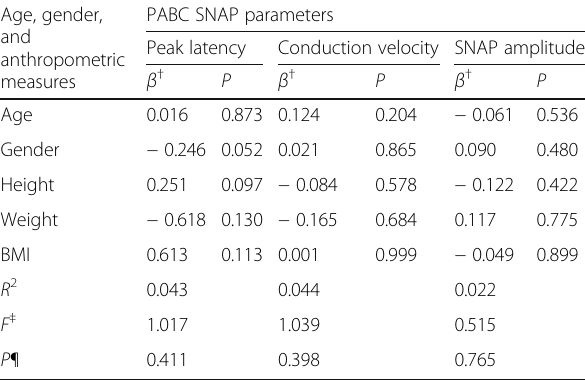
Table 6 Multiple linear regression analysis for testing the adjusted predictors ’ effects of different physiologic factors on posterior antebrachial cutaneous sensory nerve action potential parameters (120 upper limbs from 60 apparently healthy